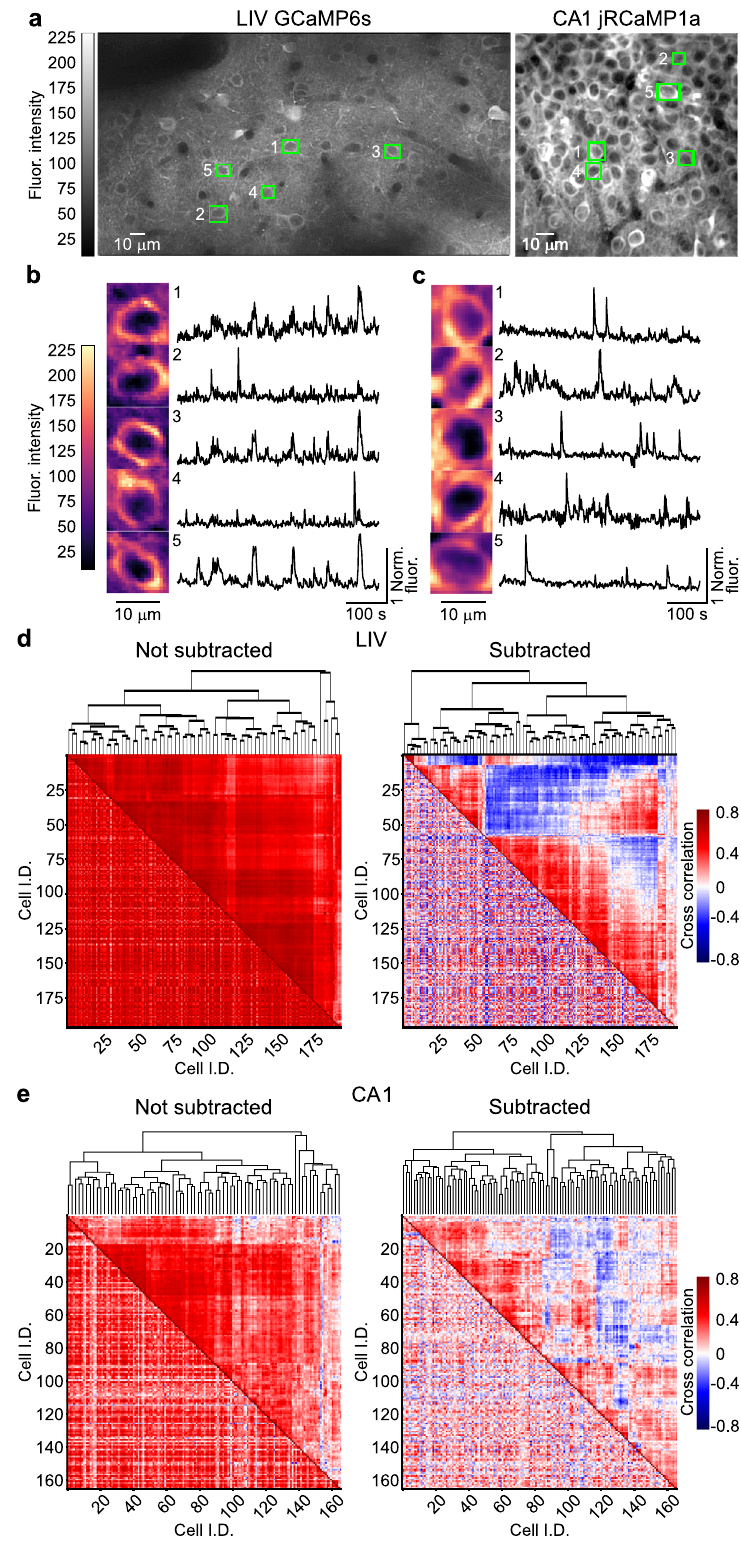
Fig. 4 Fast extraction of fl uorescence traces using CITE-On. a Fluorescence median projection showing representative FOVs from the LIV GCaMP6s (left) and the CA1 jRCaMP1a (right) datasets. True positive bounding boxes for fi ve CITE-On identi fi ed cells in each FOV are shown in green. b Left: the fi ve cells indicated in the LIV t-series displayed in a are shown at an expanded spatial scale. Right: fl uorescence traces for the cells shown in the left panel were thresholded and background subtracted (see “ Methods ” ). c Same as in b but for the CA1 t-series in a . d Lower-left triangle: cross-correlation matrix for all functional traces extracted from true positive detection in the LIV GCaMP6s t-series displayed in a . Upper-right triangle: corresponding dendrogram sorting. The left matrix shows signals before background subtraction. The right matrix after background subtraction. e Same as in d , but for the CA1 jRCaMP1a t-series shown in a